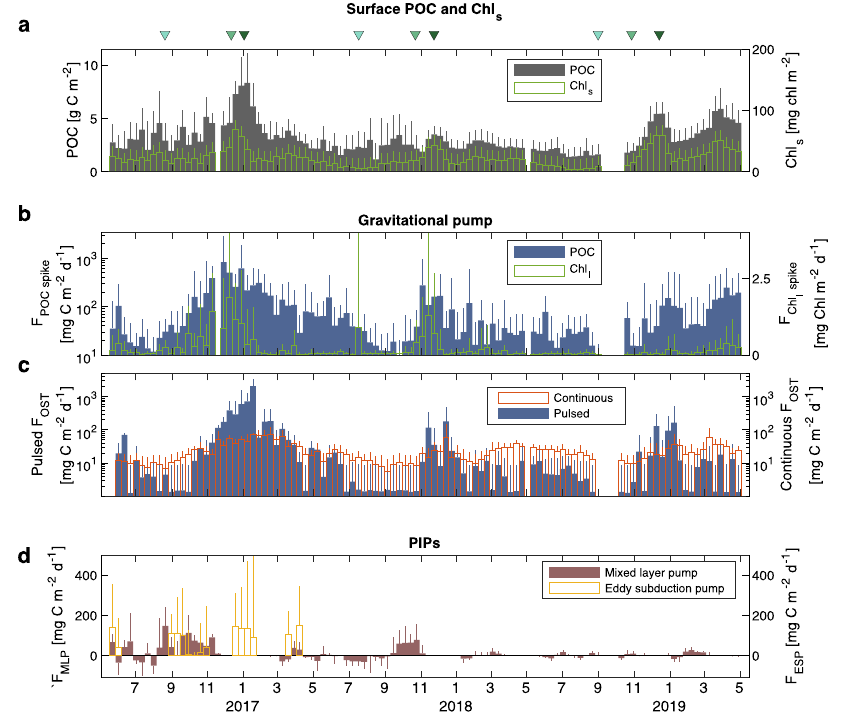
Fig. 3 | Seasonality of multiple carbon export pathways. a Stock of particulate organic carbon (POC) and small-particle chlorophyll (Chl s ) in MLD bio . b Flux of large-particle POC (blue bars) and chlorophyll (green bars) in a 100-m bin below MLD bio , derived from b bl and Chl l respectively (seeMethods). c Continuous fl ux of smallslow-sinking particles (slowly accumulating on the transmissometerwindow; red bars) and pulsed fl ux of large fast-sinking particles (creating discontinuities in transmissometer records; blue bars) measured by the optical sediment trap (OST) at ~300m (see Methods). Panels b and c show two complementary approaches to